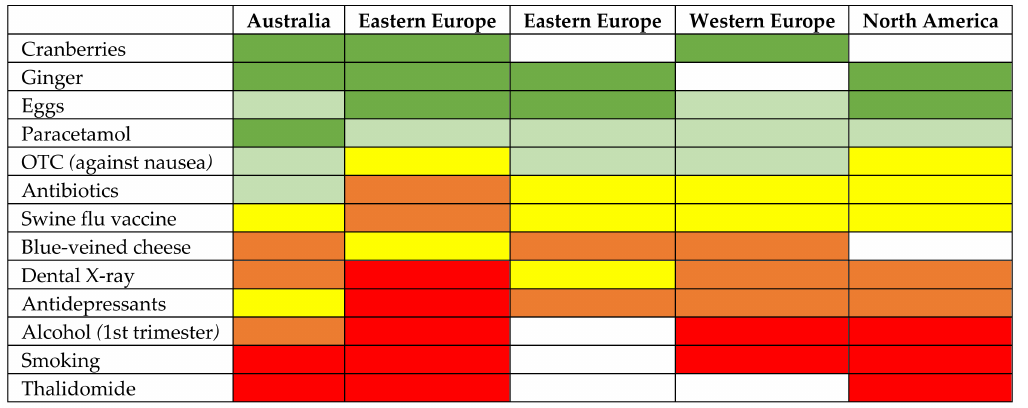
Table 4. Mean risk perception scores for 13 individual items by geographical region (dark green =